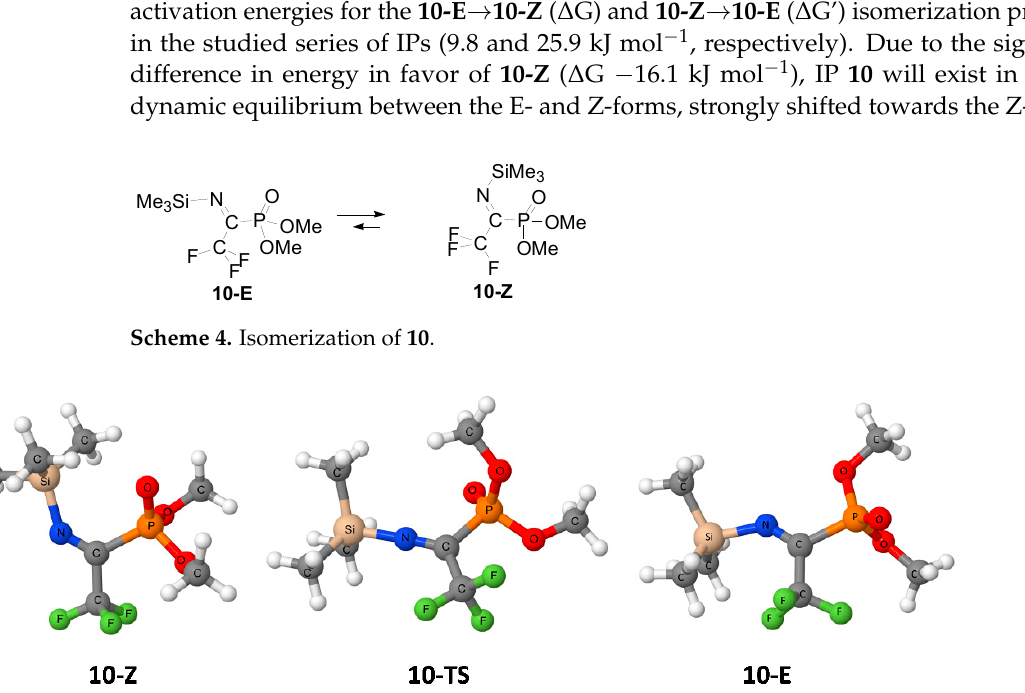
corresponding to the transition states of the isomerization reaction ( 10-TS ).